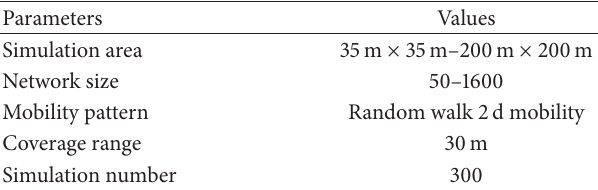
Table 3: Simulation